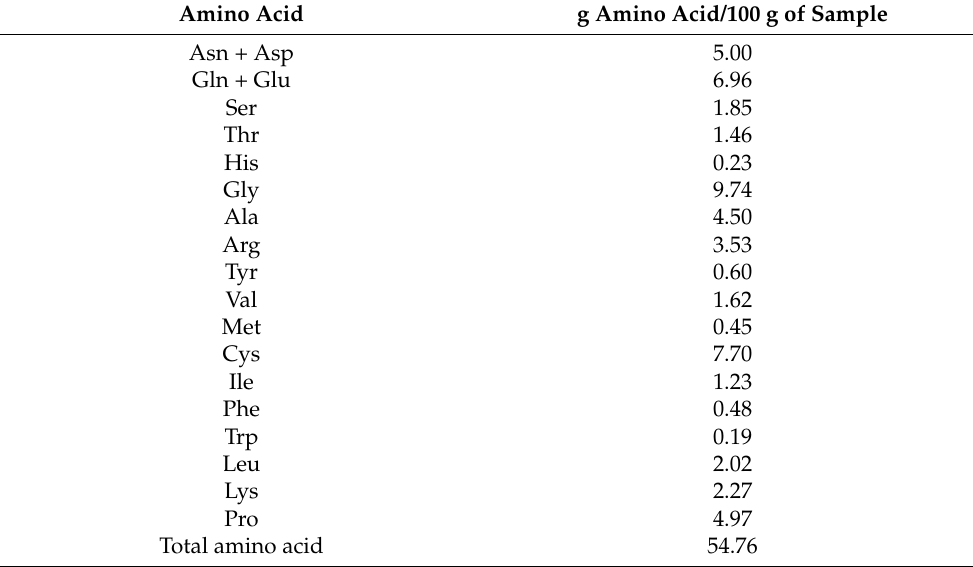
Table 4. Amino acid content in jellyfish hydrolysate using flavourzyme hydrolysis